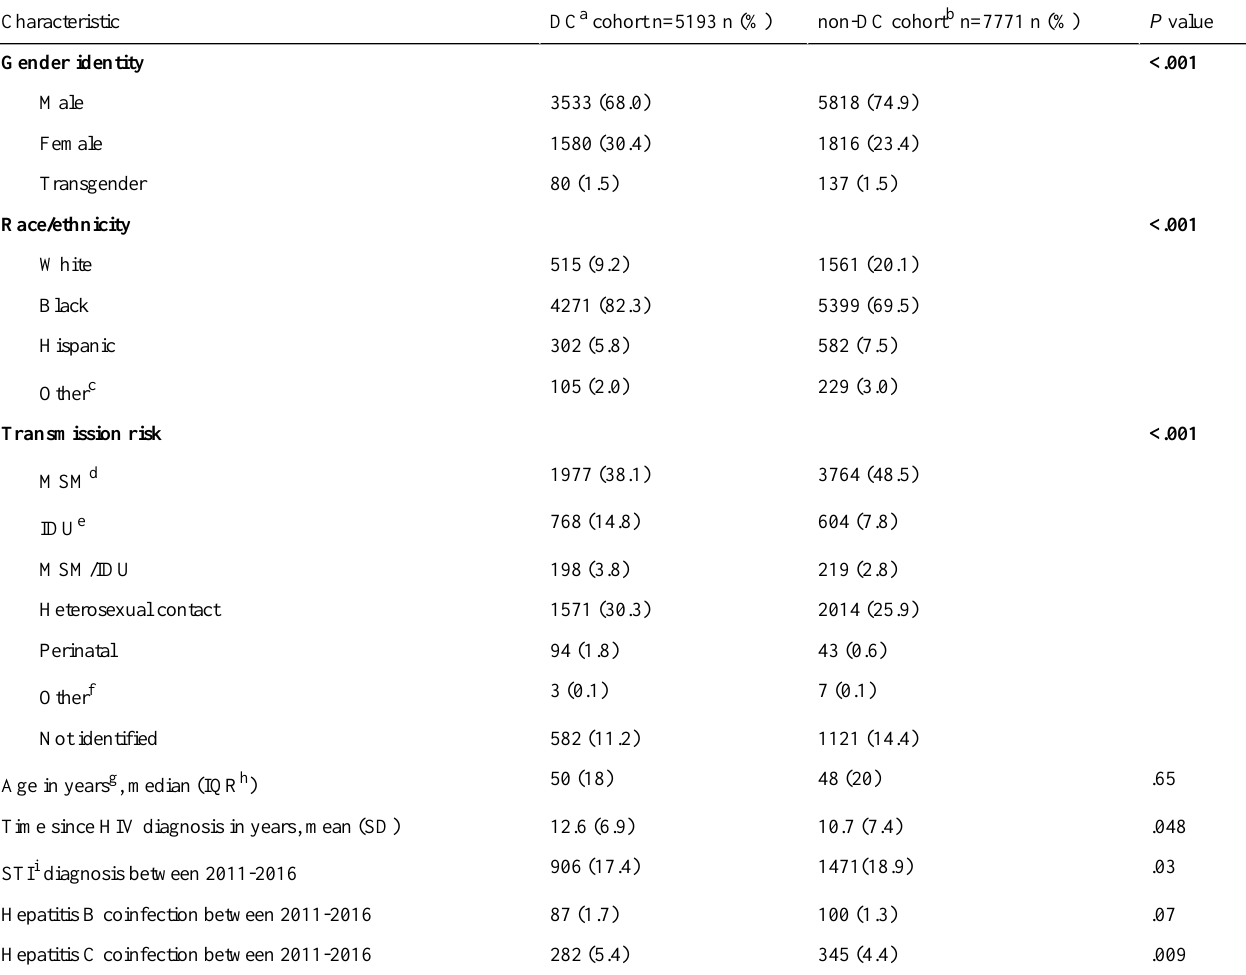
Table 2. Demographic characteristics of DC Cohort and non-DC cohort participants living in DC as of December 2017